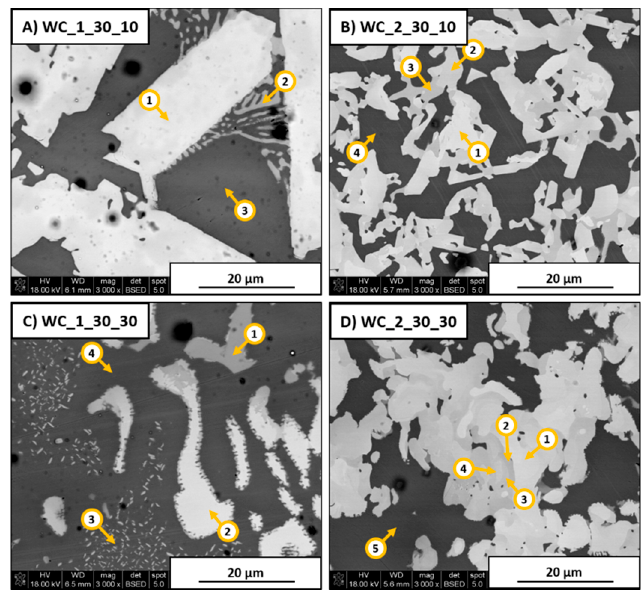
Figure 7. SEM images of Inconel 625–WC 30 wt.% samples with marked areas subjected to energy-dispersive X-ray spectroscopy (EDS) analysis. Table 4. SEM/EDS element concentration analysis results for areas marked in Figure 7 for each of samples.